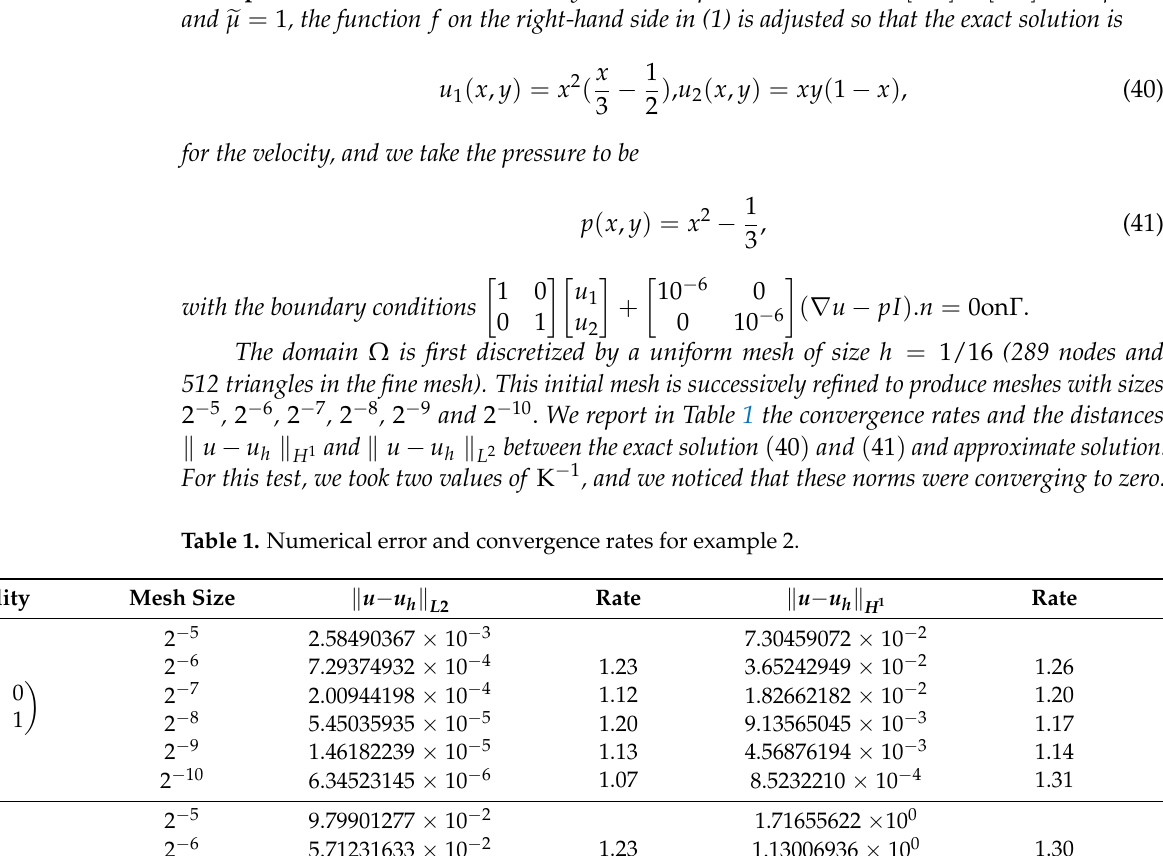
Figure 10. Isobar lines, α 1 = 10 − 4 , α 2 = 1.